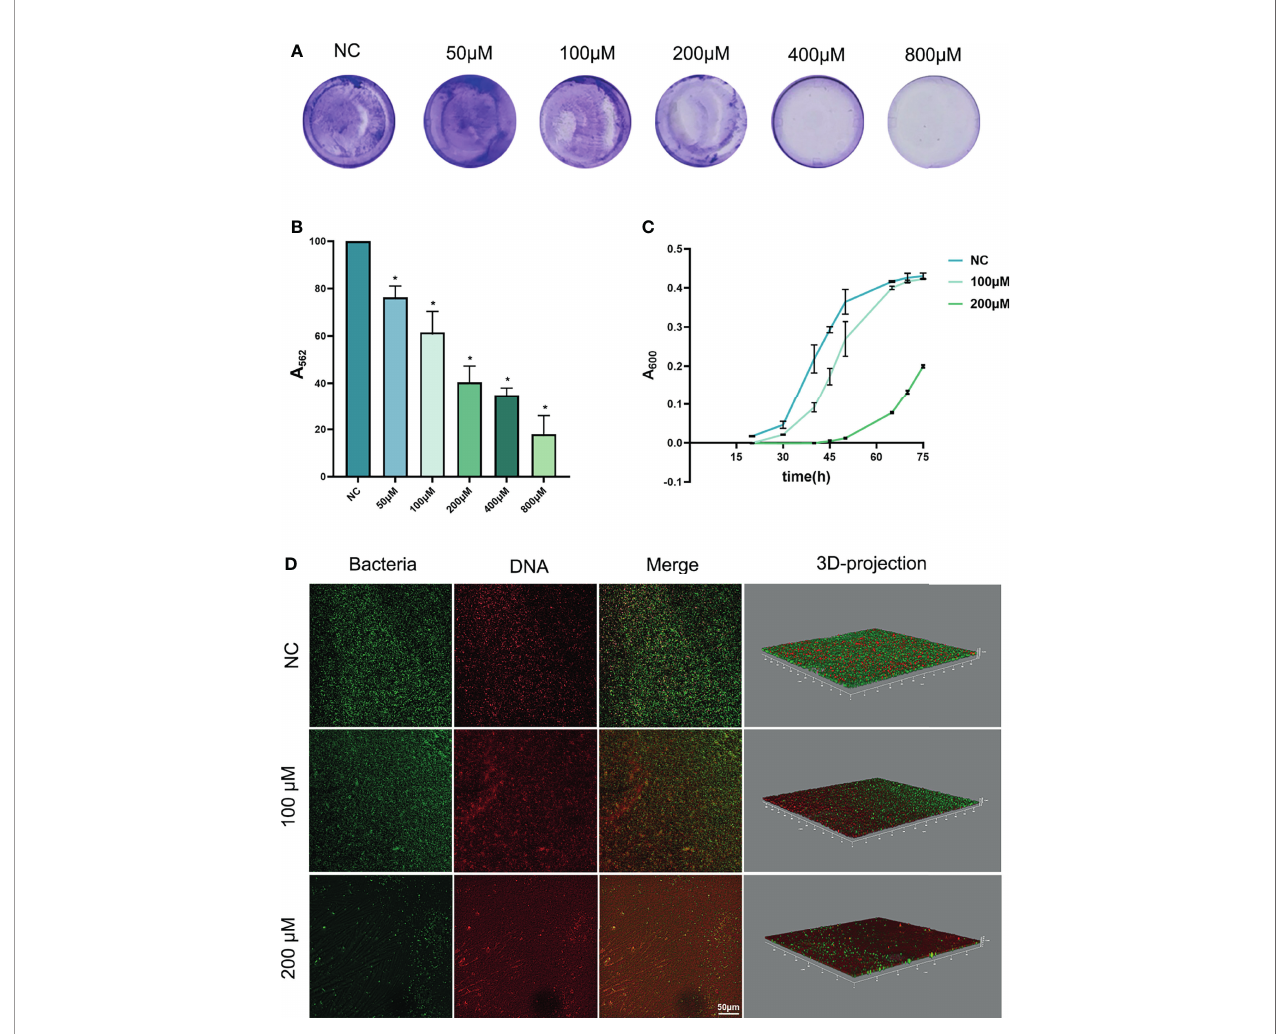
FIGURE 2 | Antibio fi lm effects of ginsenoside Rd towards P. gingivalis bio fi lms. (A) Photographs of bio fi lms stained by crystal violet, and (B) the biomass of bio fi lms was presented by the absorbance of dissolved stain. (C) Growth curves of bio fi lms. The results are shown as mean ± SD ( n = 3). * p < 0.05 versus the normal control. (D) CLSM images revealed live or dead bacteria in bio fi